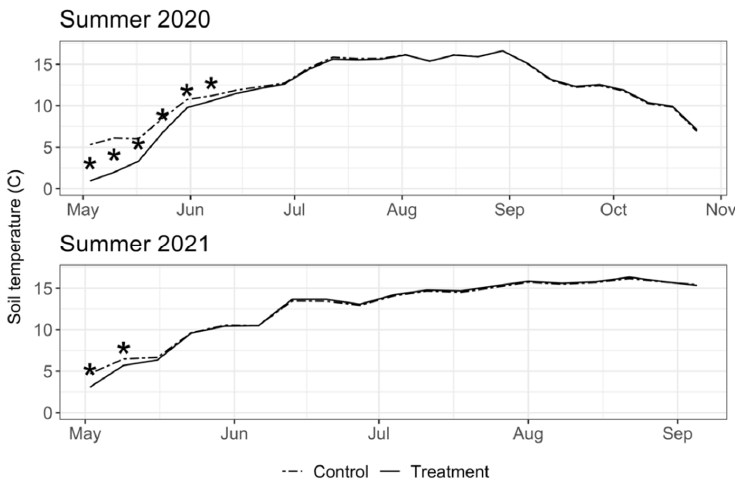
Figure 2. Mean weekly soil temperature during the growing seasons of 2020 and 2021 by treatment. Asterisks indicate weeks with significant difference between the means of the control and treatment. There was also a significant interaction between drainage class and treatment on the growing season soil temperature in both years; Supplementary Materials Table S3). Mean growing season soil temperature decreased from WD to PD (difference of 0.55–0.75 °C for